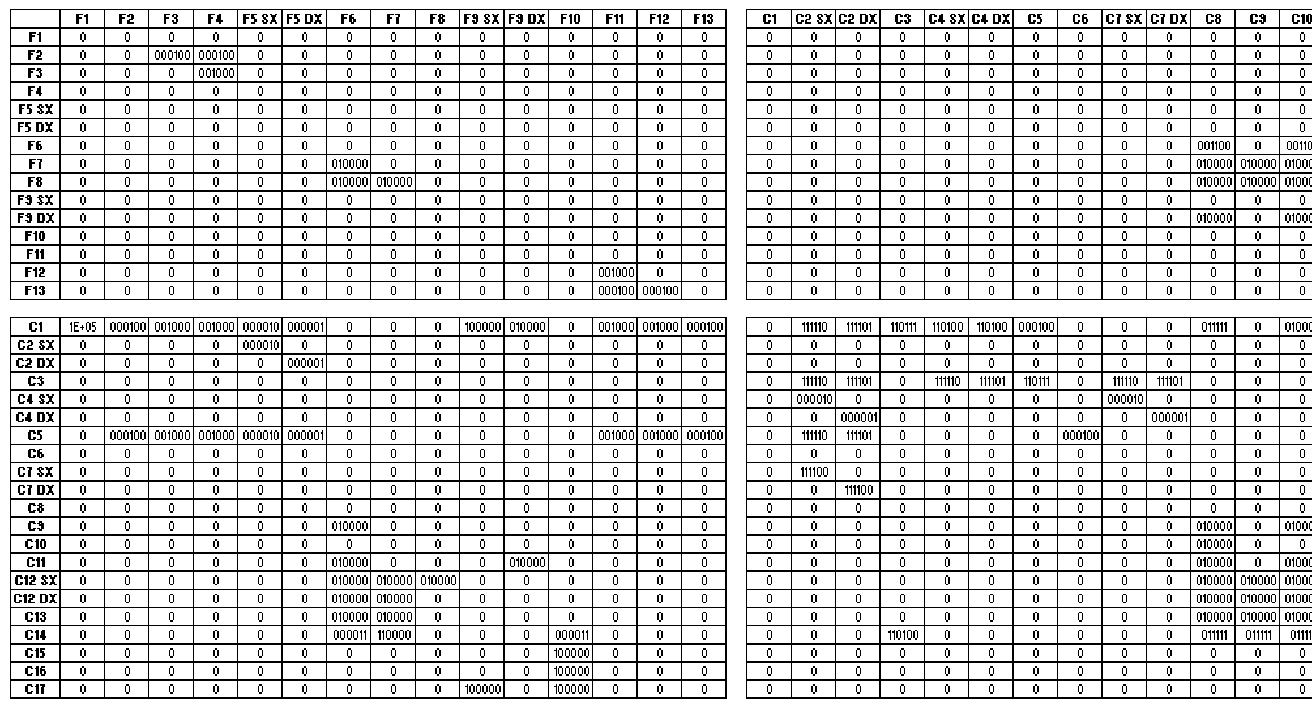
Figure 19. DPM (disassembly precedence matrix).